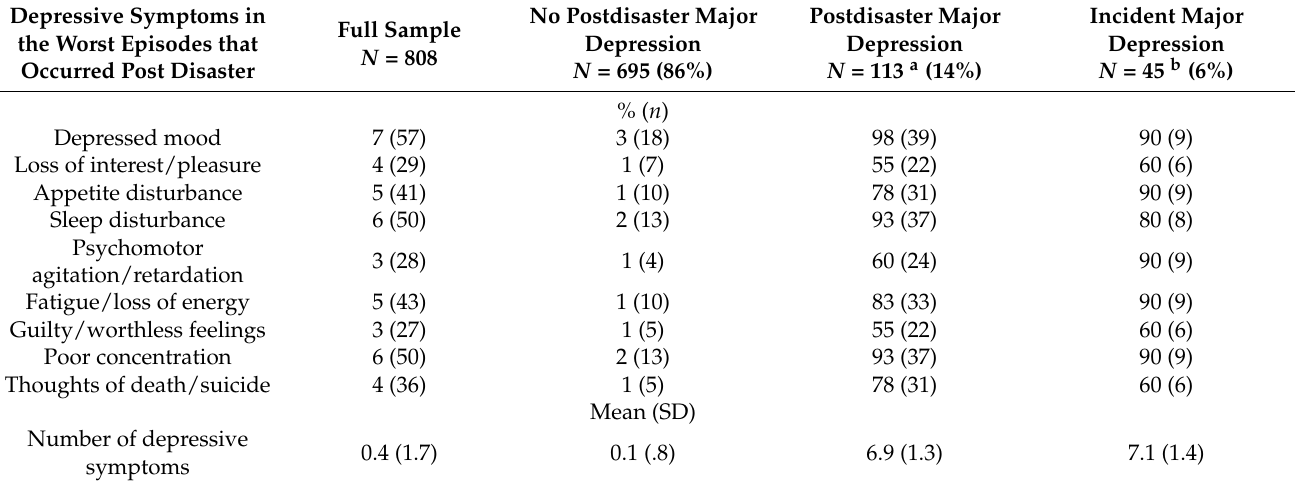
Table 1. 10-disaster database prevalence of postdisaster depressive symptoms (in worst episode only).